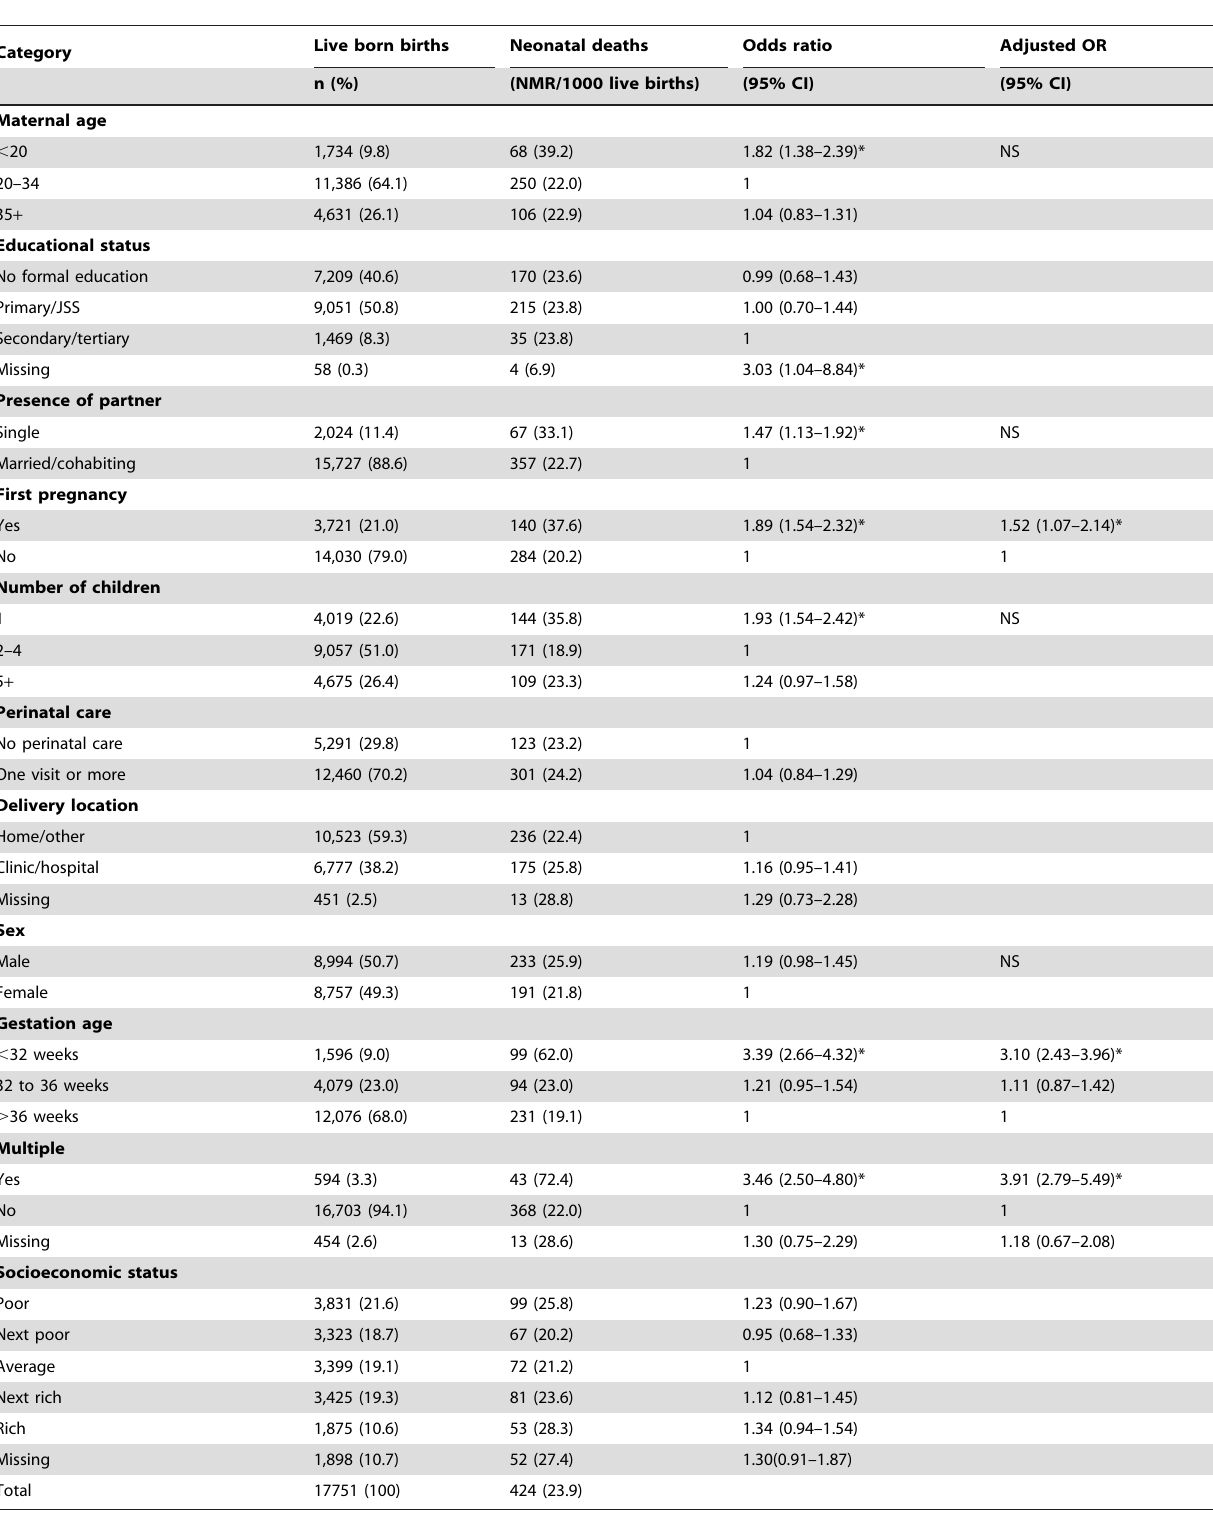
Table 2. Demographic and health characteristics of mothers and neonates, as associated with neonatal